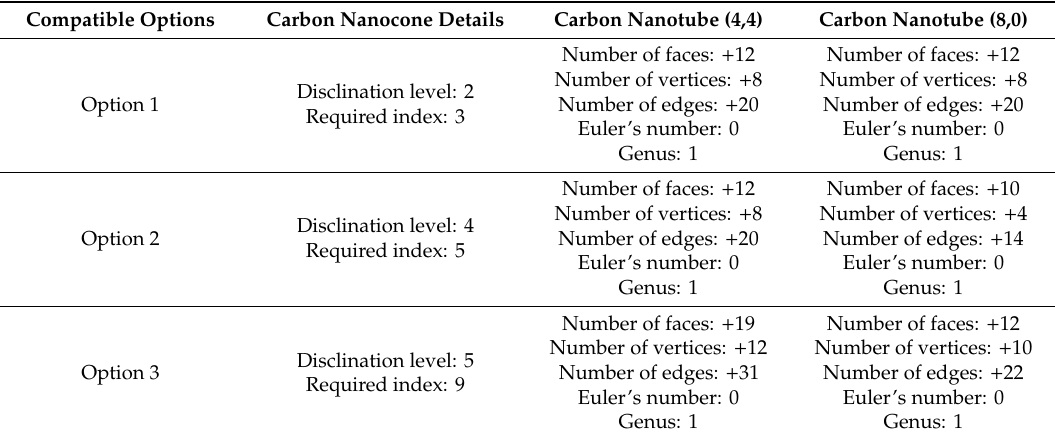
Table 3. Applied Euler’s theorem for carbon